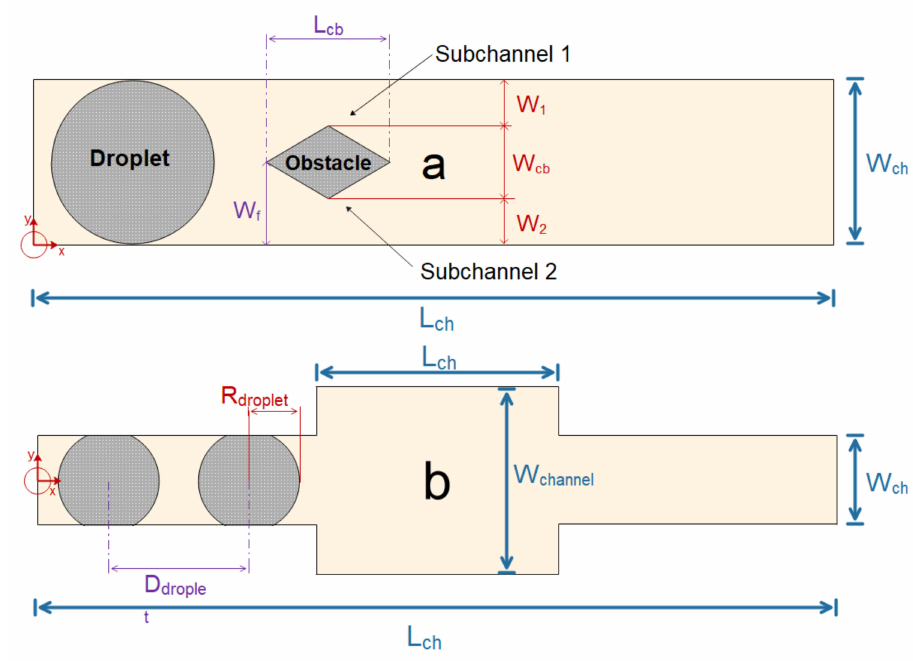
Figure 22. Configuration used for simulation of droplet deformation in a microchannel: ( a ) droplet breakup; ( b ) droplet merging